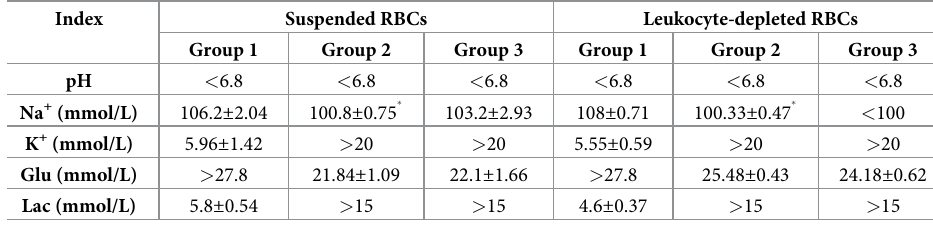
Table 1. The blood biochemical indexes over 14 days of